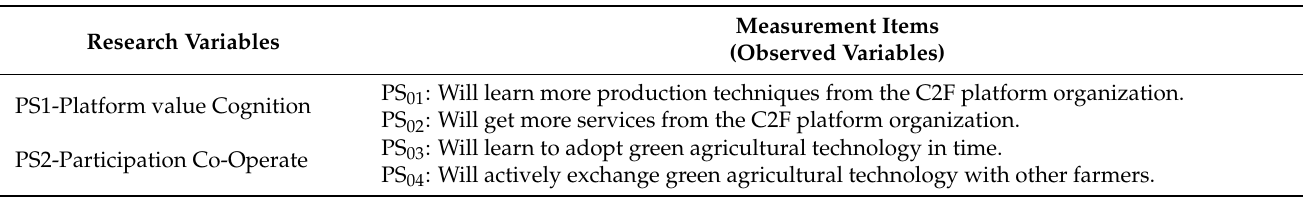
Table A1. Measurement variables of the farmers’ organized behavior to treat the risk of COVID-19 on